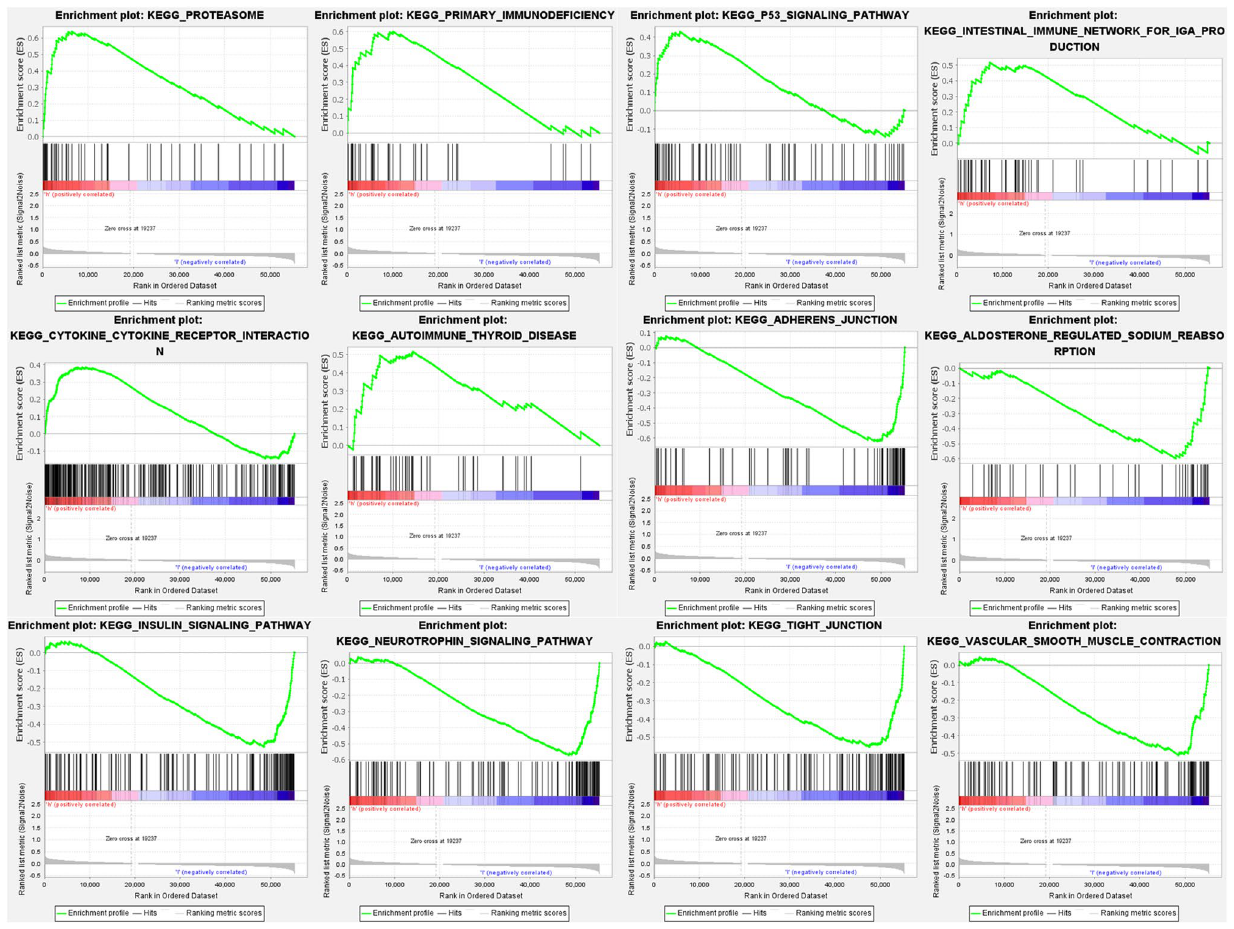
Figure 8. Enrichment analysis of GSEA for high and low-risk groups. The samples were divided into a high- risk group and a low-risk group by model calculations. The differences in the enriched pathways between the two groups were compared by GSEA enrichment analysis. Red indicates the high-risk group, and blue indicates the low-risk